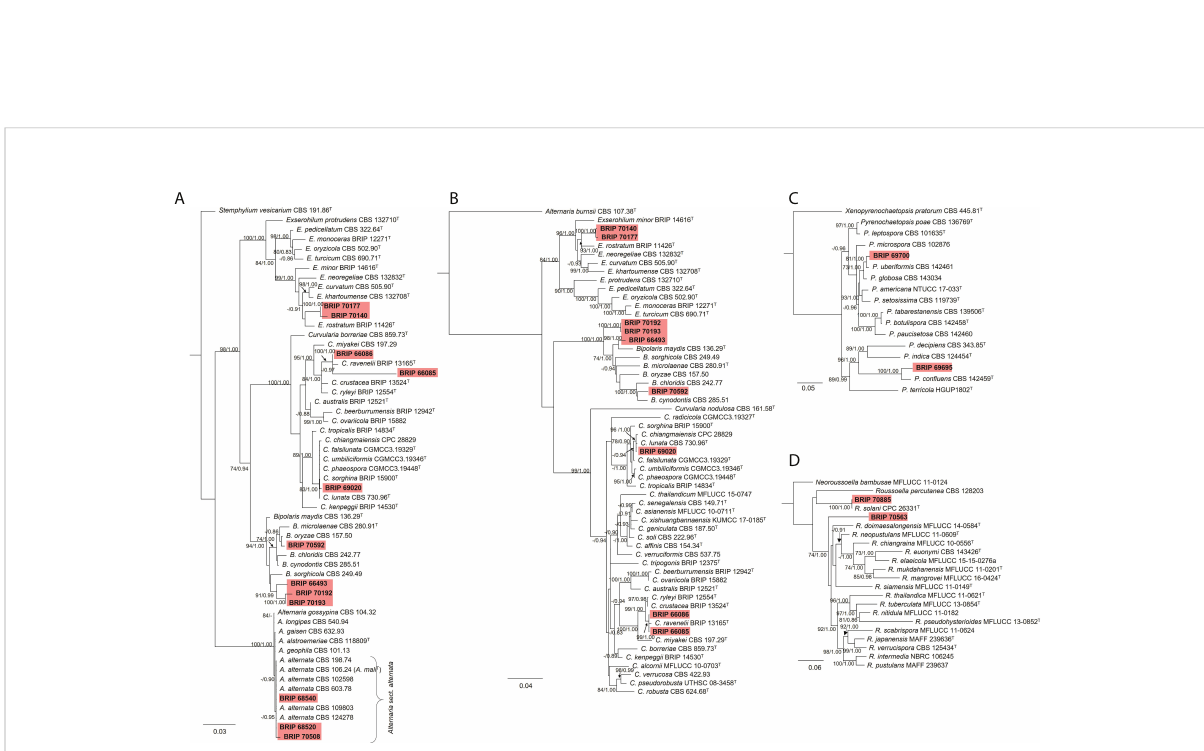
FIGURE 11 Phylogenetic trees inferred from RAxML analyses of strains in Pleosporales based on concatenated alignments of (A) ITS and LSU sequences of related species in Alternaria , Bipolaris , Curvularia , and Exserohilum (Pleosporaceae); (B) gapdh , rpb2 and tef1- a sequences of related species in the Bipolaris , Curvularia , and Exserohilum (Pleosporaceae); (C) LSU, ITS, rpb2 and tub2 sequences of related species in Pyrenochaetopsidaceae; and (D) ITS, LSU, rpb2 and tef1- a sequences of related species from Roussoellaceae. RAxML bootstrap (bs) values greater than 70% and Bayesian posterior probabilities (pp) greater than 0.8 are given at the nodes (bs/pp). In bold font are the isolates from this study, and ex-type strains are indicated with T .